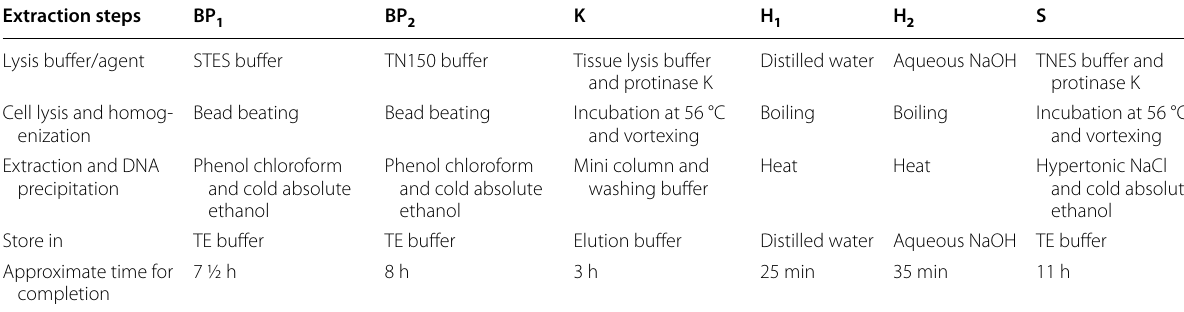
Table 1 Comparison of six different DNA extraction methods examined in this study